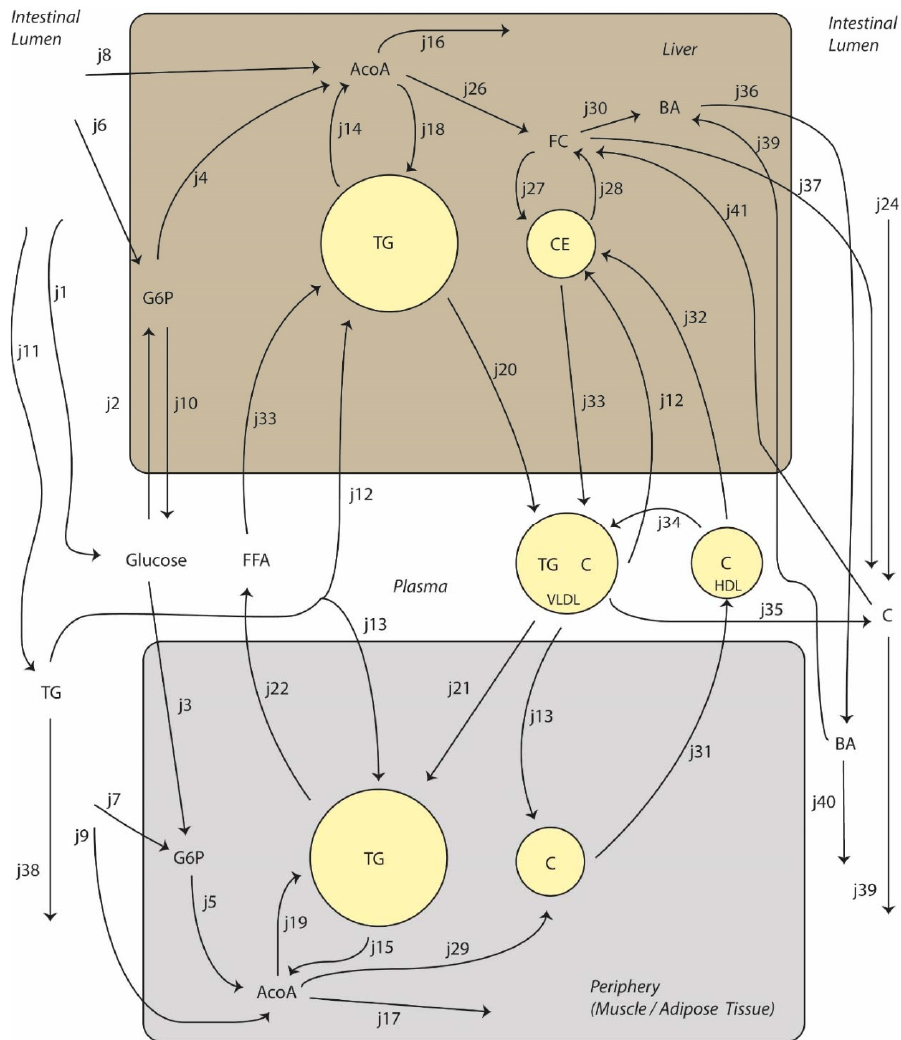
Figure 1. Schematic of the MINGLeD model. The MINGLeD model consists of four compartments (liver, plasma, periphery and intestinal lumen), 18 states and 41 fluxes. Food intake is modeled as glucose entering the plasma (j1), triglyceride (TG, j11) and cholesterol (C, j24) entering the intestinal lumen, whereas amino acids from protein are distributed to liver and periphery at the level of glu ‐ cose ‐ 6 ‐ phosphate (G6P, gluconeogenic) or acetyl ‐ CoA (AcoA, ketogenic) (j6, j7, j8, j9). Glucose in the plasma is absorbed by liver (j2) and periphery (j3) to enter the Krebs cycle (j16, j17) or to be used for biosynthetic processes, such as de novo lipogenesis (j19) or cholesterol (j26, j29) and bile acid syn ‐ thesis (j30). TG from the intestinal lumen can be absorbed by the liver (j12) or periphery (j13) and be used for beta ‐ oxidation (j14, j15) or redistribution as VLDL (j20) or free fatty acids (FFA, j22). Ab ‐ sorbed dietary cholesterol first enters the liver (j41) where it can be used for bile acid synthesis (j30) or redistributed to the periphery in the form of VLDL ‐ C (j33, j13). Peripheral cholesterol pools can return to the liver through HDL ‐ C (j31, j32) or VLDL ‐ C after action of cholesteryl ester transfer pro ‐ tein (j34, j12). Cholesterol can be cleared from the body through biliary cholesterol secretion (j37) or trans ‐ intestinal cholesterol secretion (j35).